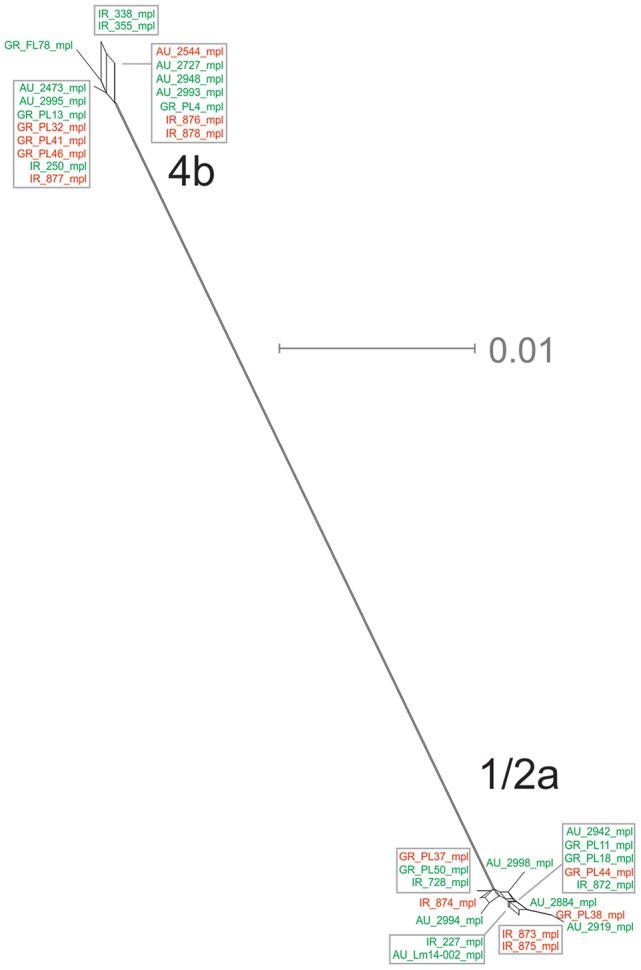
Phylogenetic network applied to virulence gene mpl using the Neighbor-Net algorithm. L. monocytogenes strains represented food environment isolates (green color) or clinical isolates (red color), isolated in Ireland (IR), Greece (GR), and Australia (AU). Strains clustered together in a box represent identical nucleotide sequence.